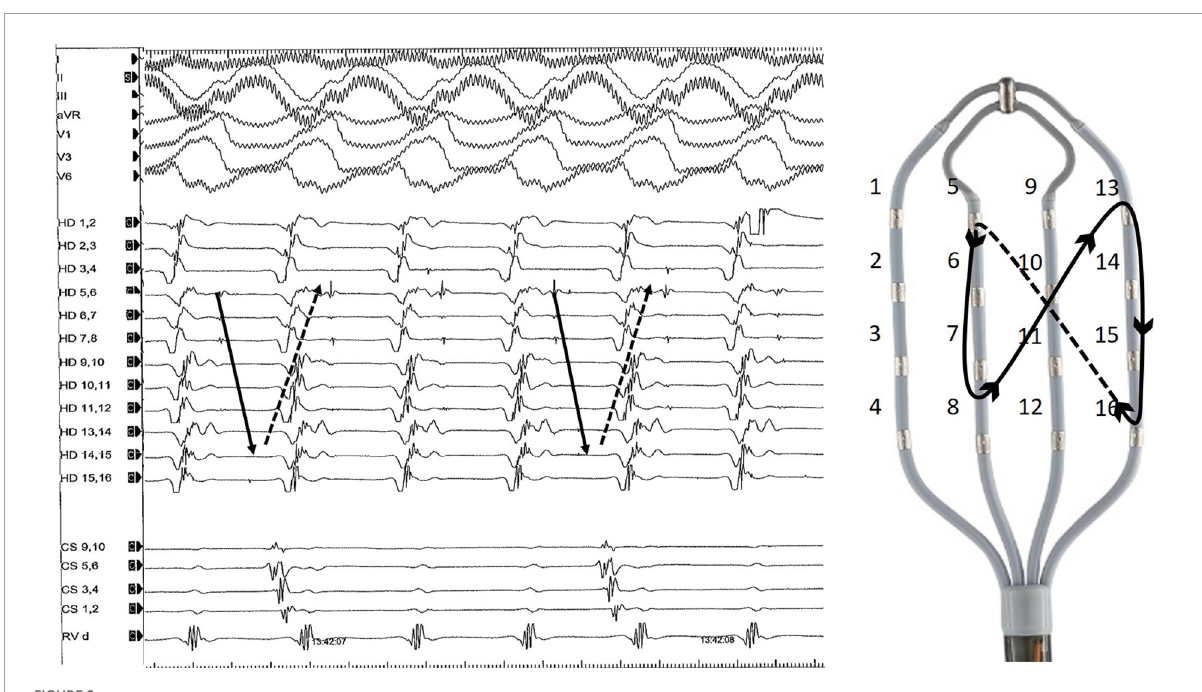
FIGURE2 Representative example of diastolic Purkinje potentials during an organized ventricular arrhythmia. The tachycardia was induced by programmed right ventricular stimulation and degenerated into VF. On the right side of the figure is an example of a multipolar diagnostic catheter (HD Grid, Abbott) and Purkinje activation